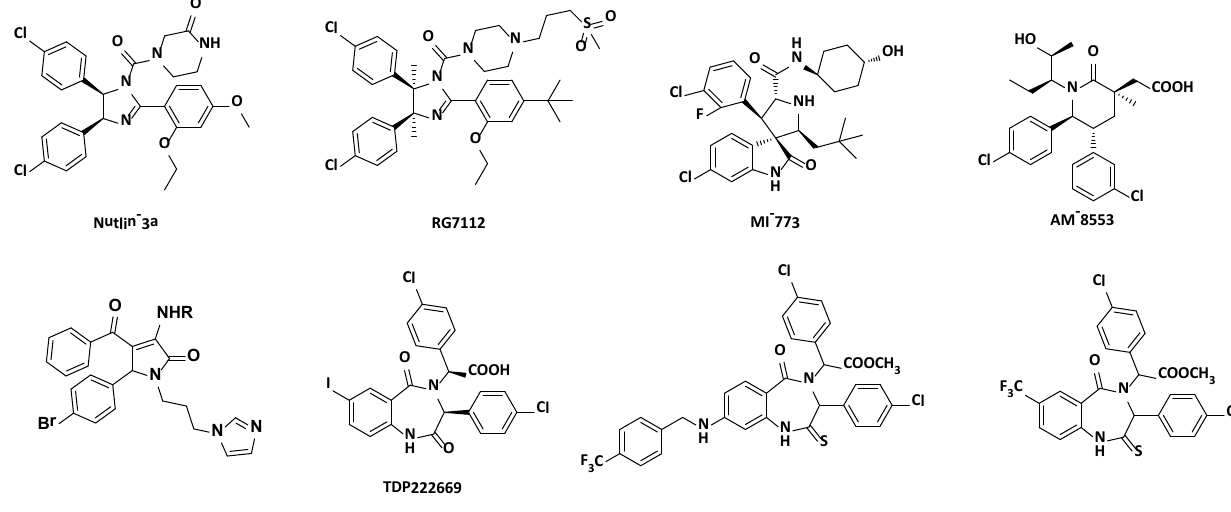
Figure 1. Representative p53-murine double minute 2 (MDM2)